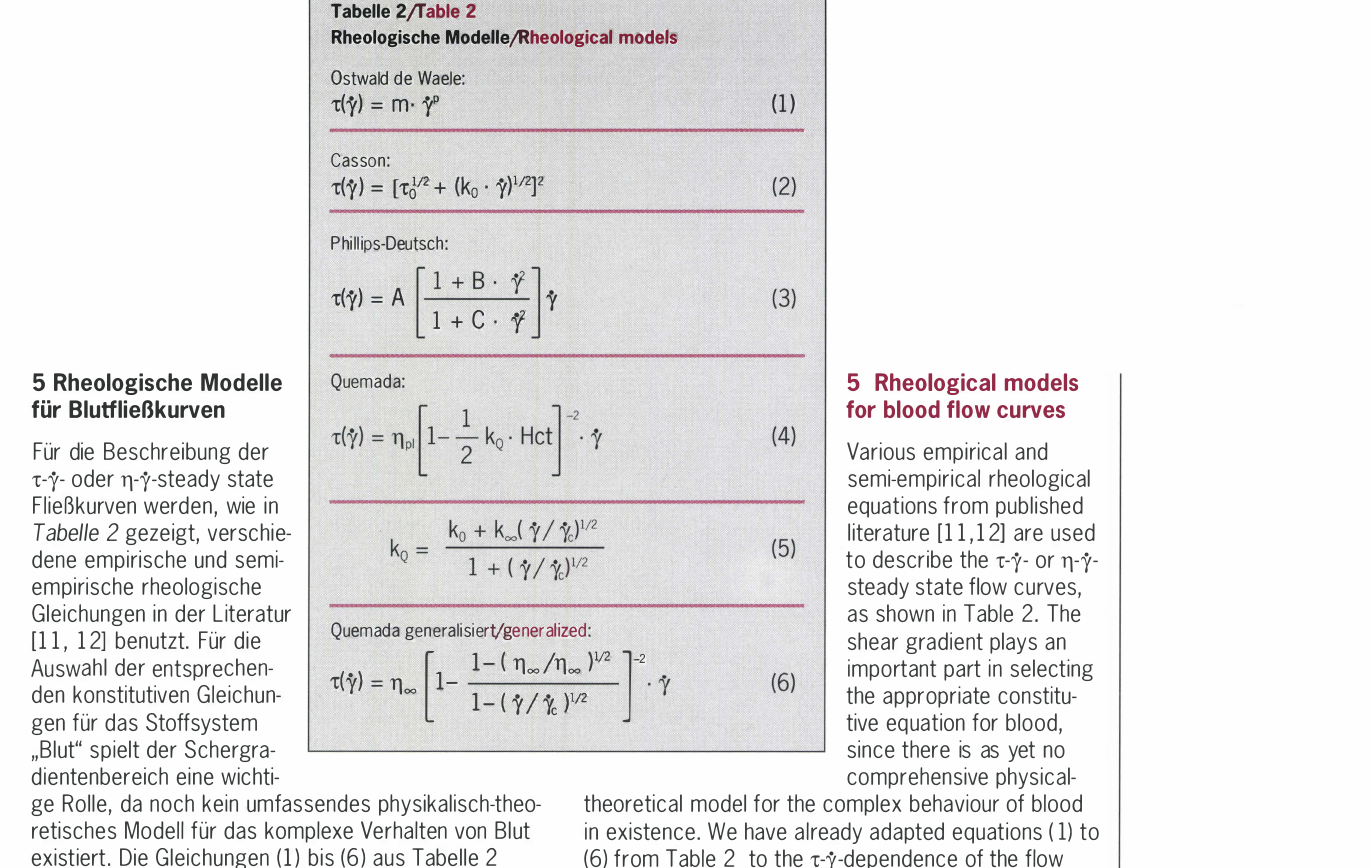
(6) from Table 2 to the r-y-dependence of the flow curves for Hct-standardised blood samples (Hct 0.45) taken from 34 healthy persons (these curves having been obtained with the Low Shear 40 instru­ ment) using non-linear fit programs. The best adapta­ tion, measured on the mean square deviation, was found to be for the Quemada equation